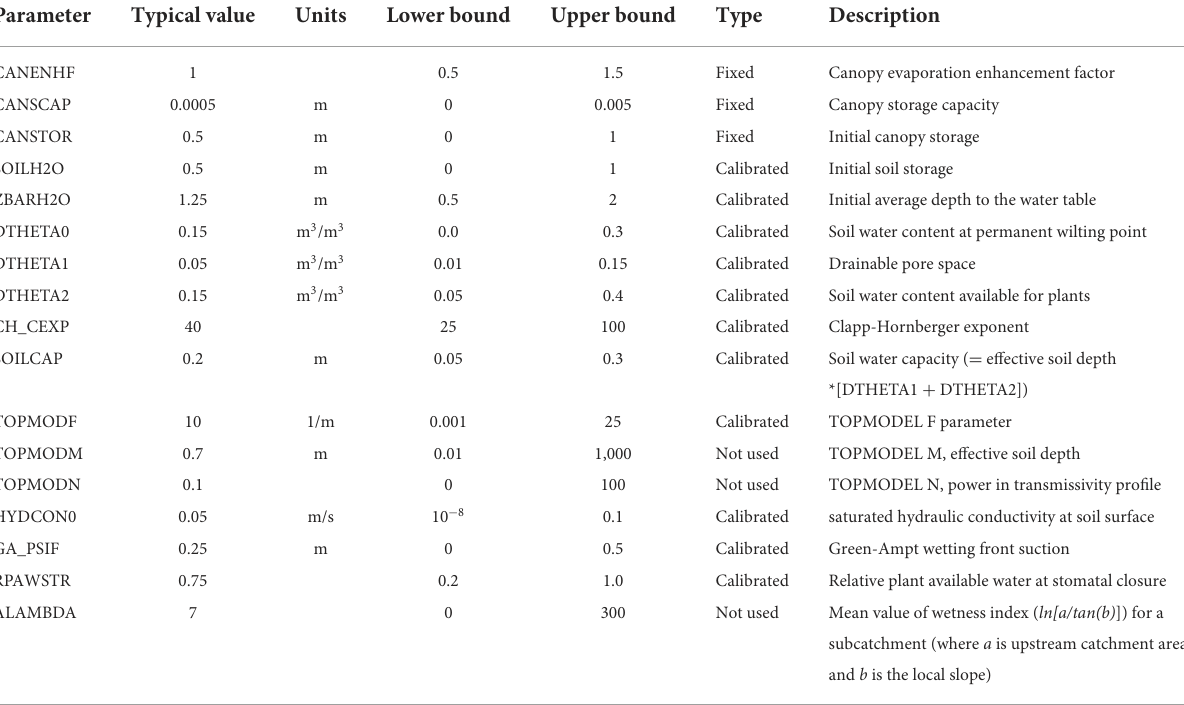
TABLE 1 TopNet soil water balance module